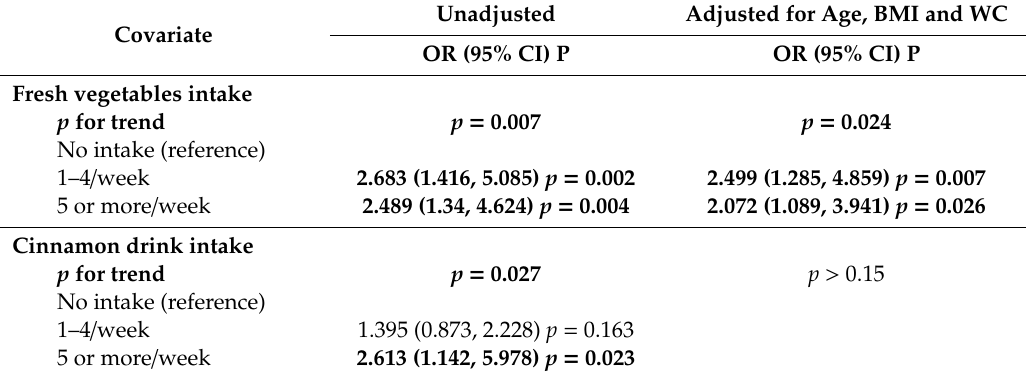
Table 5. Unadjusted and adjusted Odds Ratio (OR) with its 95% Confidence Interval (CI) for the predictors of dyslipidemia in